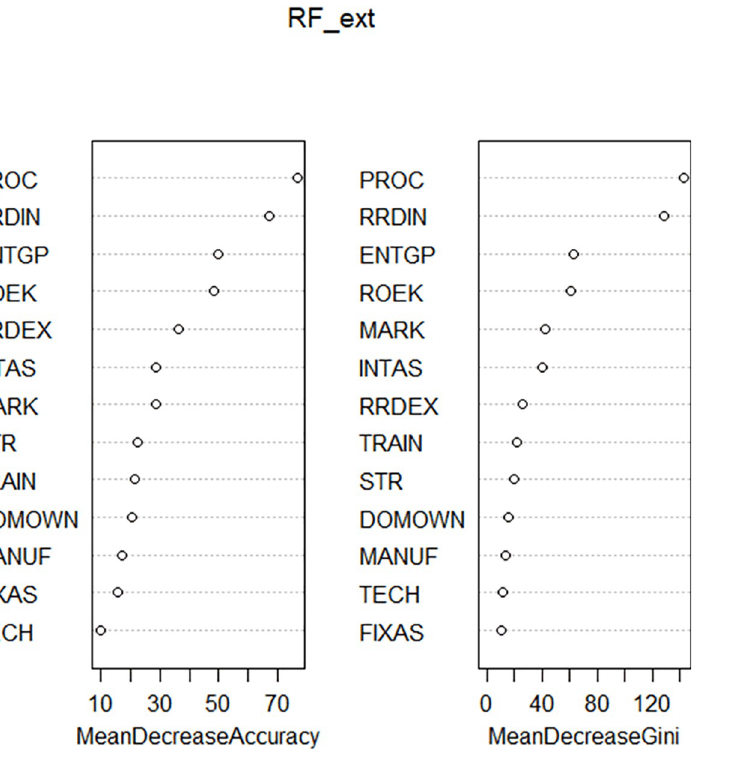
Fig 5. Importance of selected innovation determinants–Model